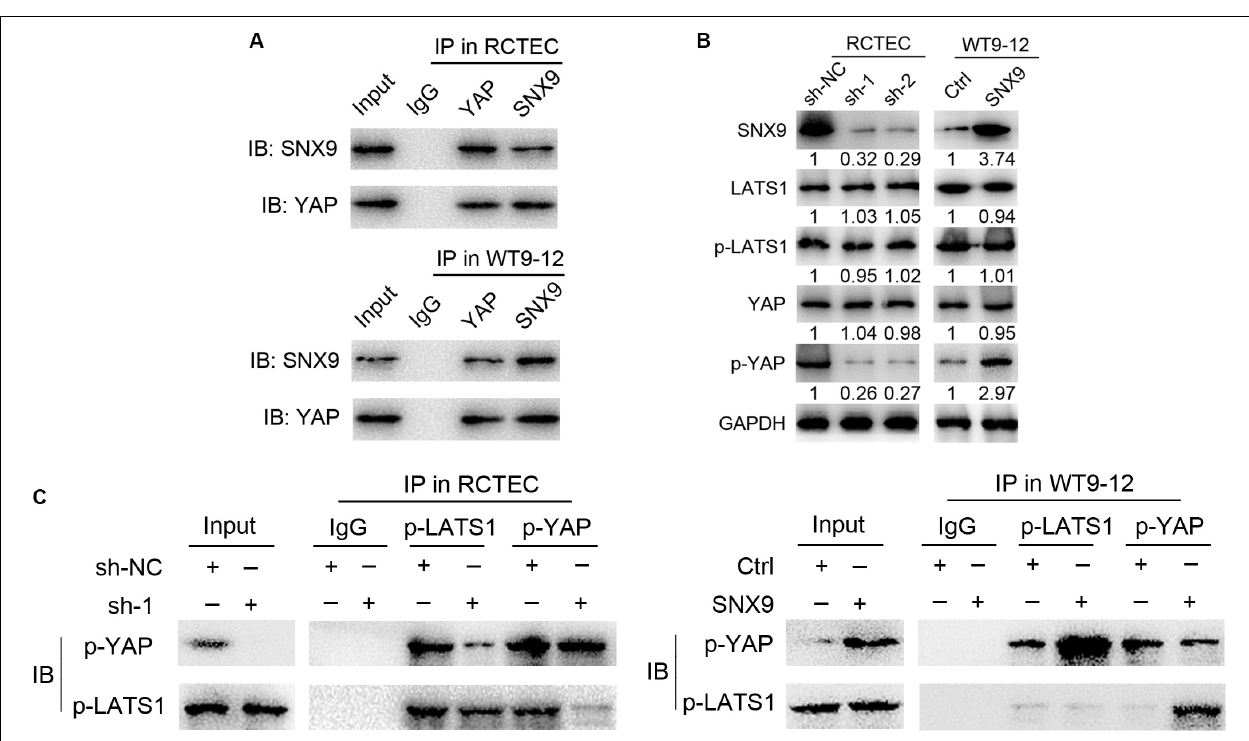
FIGURE 6 | SNX9 promotes LATS1 binding and phosphorylation of YAP, to activate the Hippo signaling pathway. (A) Co-IP experiments examining the interaction between SNX9 with YAP in RCTEC and WT9-12 cells. (B) Western blot analysis was performed to examine the p-LATS1, p-YAP, total LATS1, and total YAP protein levels of the indicated cells. (C) Co-IP experiments examining the interaction between p-YAP and p-LATS1 in the indicated cells, with modified SNX9 expression